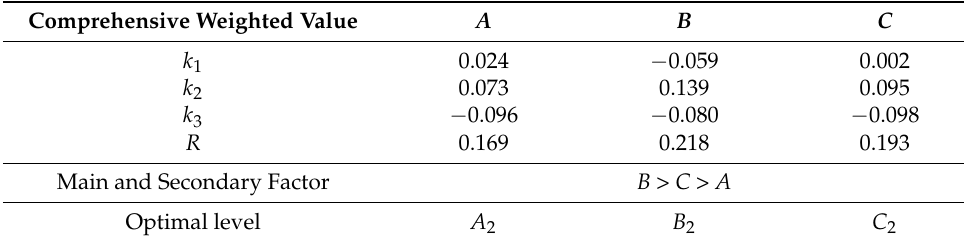
Table 6. The range analysis of comprehensive